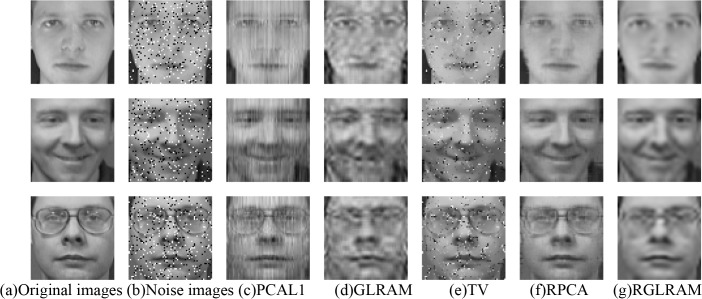
Comparison of low rank recovery and denoising on ORL.This face dataset is open and can be downloaded freely at http://www.cl.cam.ac.uk/research/dtg/attarchive/facedatabase.html. It is publicly available for face recognition research, and the consent was not needed.